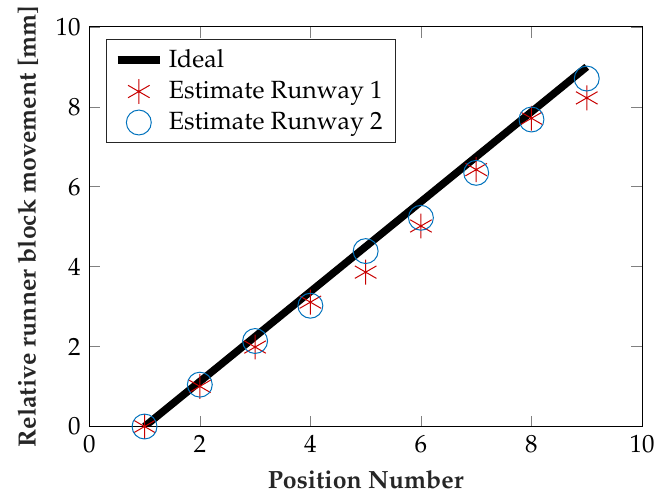
Figure 14. Position estimation performance.